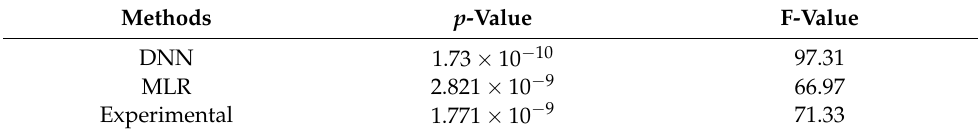
Table 5. Analysis report of DNN, MLR and experimental values for methylene blue